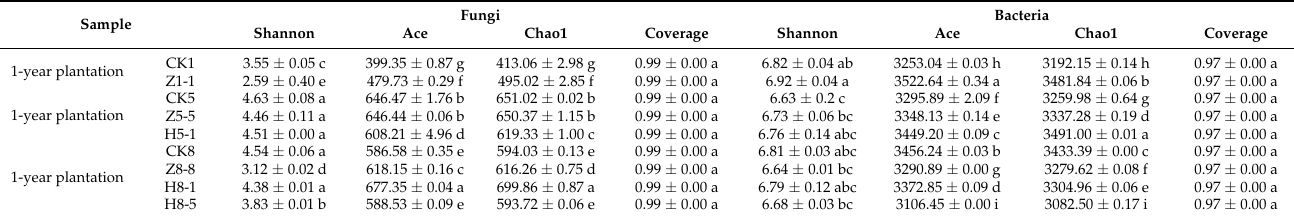
Table 3. Indices for the microbial diversity of soil planted with herbaceous peony.